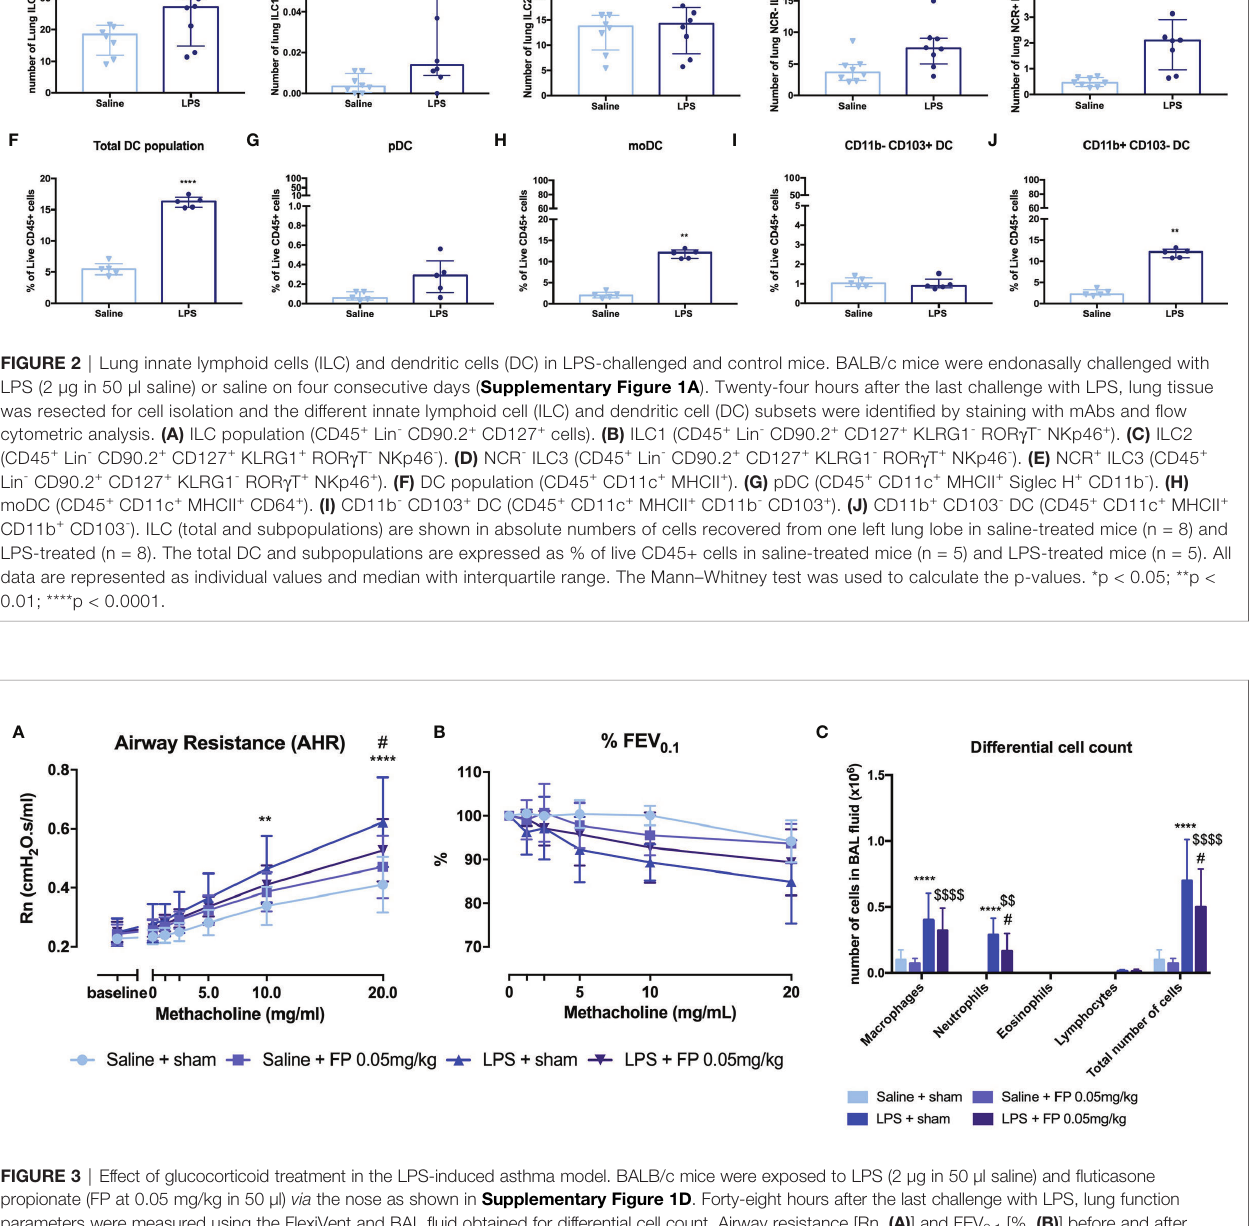
with anti-Ly6G mAb when compared to LPS-exposed untreated mice ( Figure 4F ). On the contrary, lung KC, MIP-1, IL-1 b , IL- 17A, TNF- ⍺ , IL-6, and IL-13 levels were even higher after treatment with anti-Ly6G mAb than without neutrophil